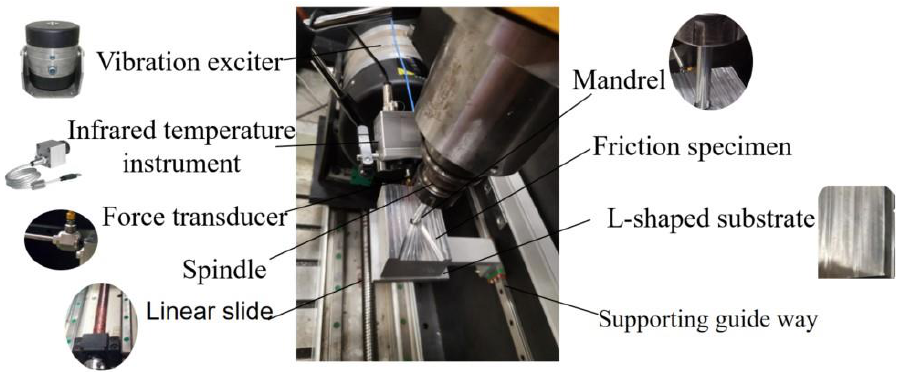
Figure 17. Photograph of the setup for measuring the temperature rise due to tool deflection and friction.